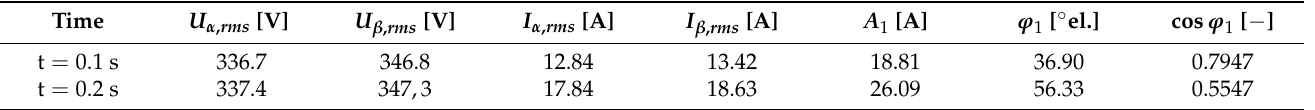
Table 35. Simulation results before and after the change (at steady states).